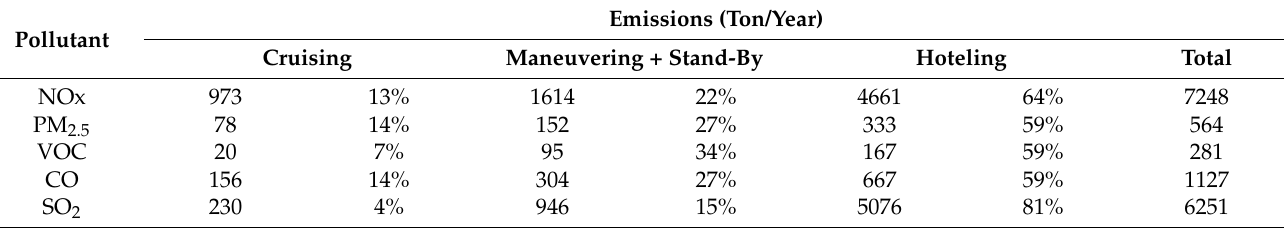
Table A18. Total emissions from vessels (Ashdod, 2018).